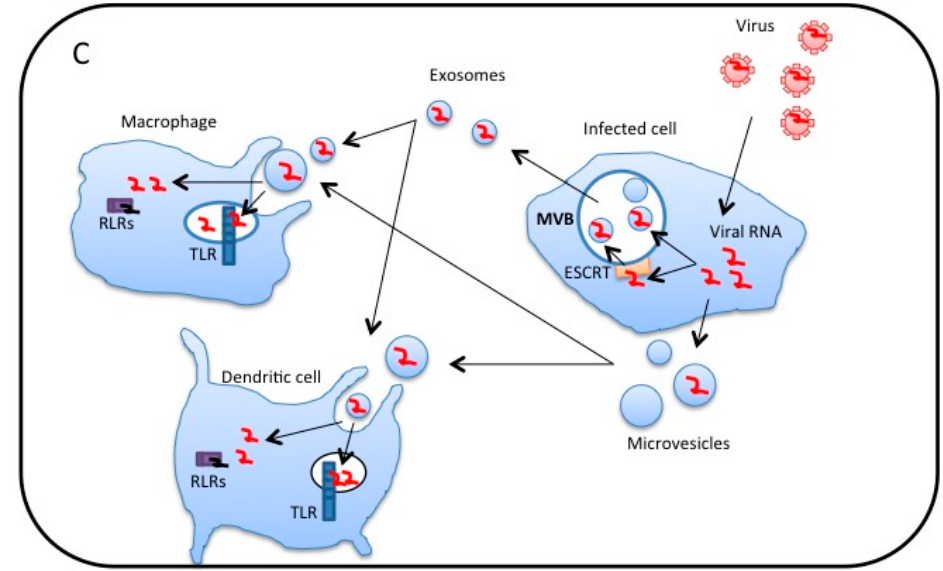
Figure 1. Recognition of viral RNA by pattern recognition receptors. ( A ) Dendritic cells and macrophages internalize virus particles through phagocytosis. Viral RNAs are internalized into endosomes, wherein Toll-like receptors (TLRs) recognize the viral RNA and trigger the signal to induce innate immune responses; ( B ) Some kinds of viruses infect dendritic cells and macrophages. Viral RNA is released into the cytoplasm. Cytoplasmic viral RNA sensors, RIG-I-like receptors (RLRs), detect the viral RNA in the cytoplasm and trigger innate immune responses; ( C ) In virus-infected cells, viral RNAs are sorted into exosomes and microvesicles via endosomal sorting complexes required for transport (ESCRT) or unknown factors. Dendritic cells and macrophages internalize extracellular vesicles (EVs) containing viral RNAs, which are released into endosomes and are recognized by TLRs, resulting in innate immune responses. Viral RNAs released into the cytoplasm were recognized by RLRs.